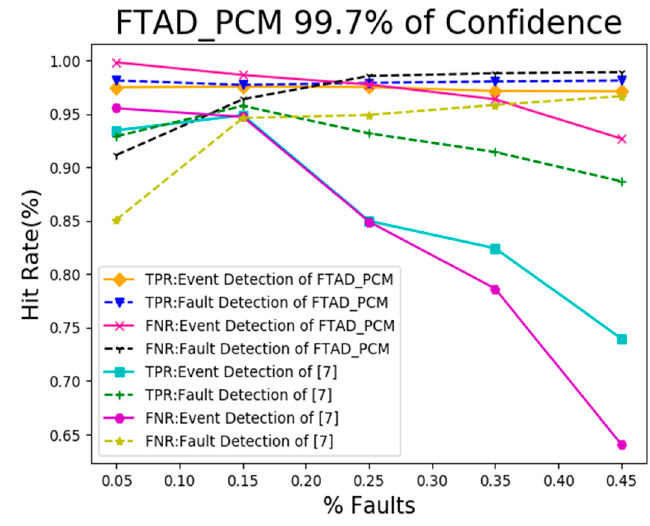
Figure 4. FTAD_PCM detection rate vs. the rate of sensor faults. Information 2018 , 9 , x FOR PEER REVIEW